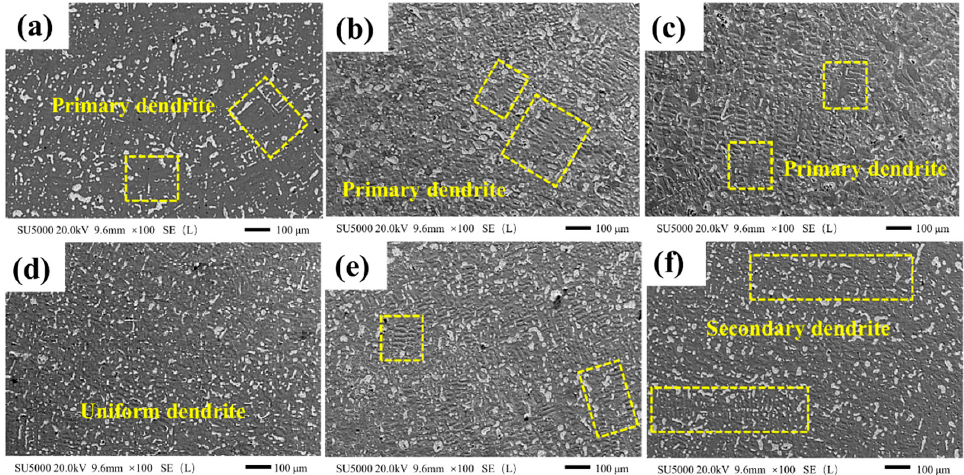
Figure 5. Copper layers dendrite morphology at different solidification temperatures. ( a ) 400 ◦ C, ( b ) 500 ◦ C, ( c ) 600 ◦ C, ( d ) 700 ◦ C, ( e ) 800 ◦ C, and ( f ) 900 ◦